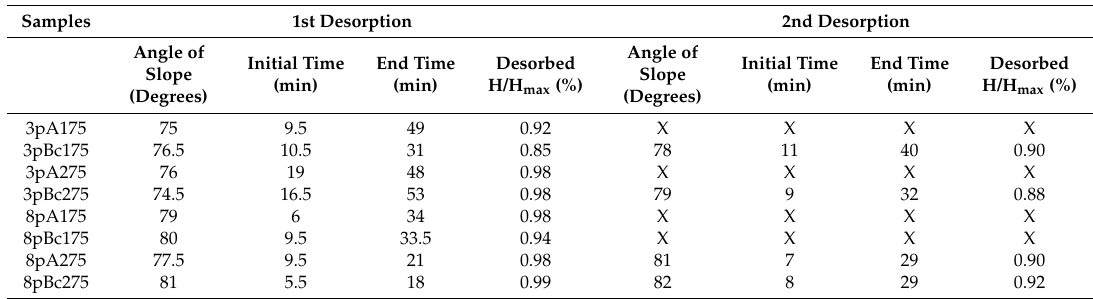
Table 2. Graphical parameters collected from desorption traces—Slope of the linear part. Initial Time (~incubation). End Time from linear extrapolation to H = 0. Desorbed amount relative to H max . X means that no sample was achieved